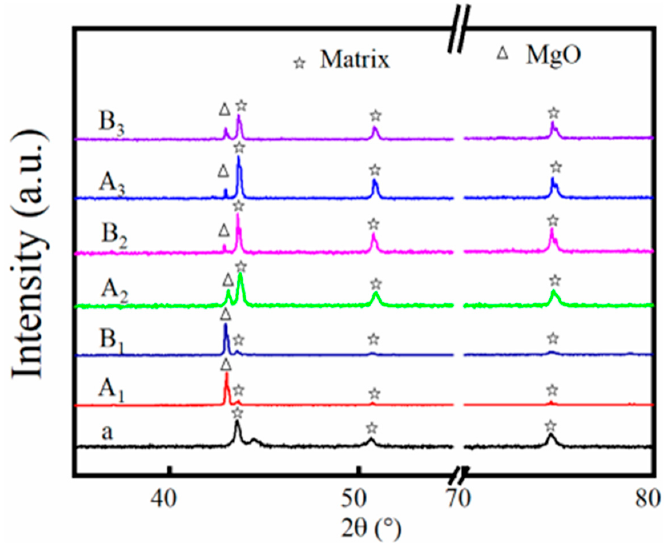
Figure 7. XRD patterns of the original 316SS (a) and corroded 316SS in salts A (A 1 ,A 2 ,A 3 ) and B (B 1 ,B 2 ,B 3 ) under Ar for 100 h at 500 °C (A 1 ,B 1 ),600 °C (A 2 ,B 2 ) and 700 °C (A 3 ,B 3